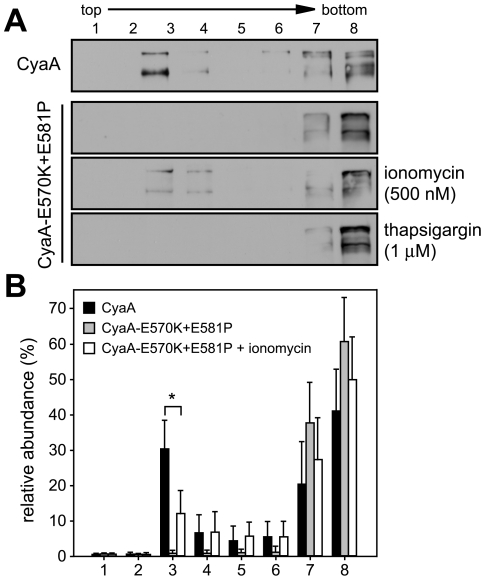
Mobilization of CyaA into lipid rafts depends on influx of extracellular Ca2+ ions into cells.(A) J774A.1 cells were incubated at 37°C for 10 min with 1 nM CyaA and CyaA-E570K+E581P, in the presence or absence of 500 nM ionomycin , or of 1 µM thapsigargin, respectively. Cell lyzates were analyzed on sucrose density gradients as above. The blots are representative of four independent experiments. (B) Distribution of CyaA proteins in gradient fractions was quantified as in Fig. 1 and the values represent the mean ± S.D. of three independent experiments. An asterisk indicates a statistically significant difference (*, p<0.05; Student's t test).